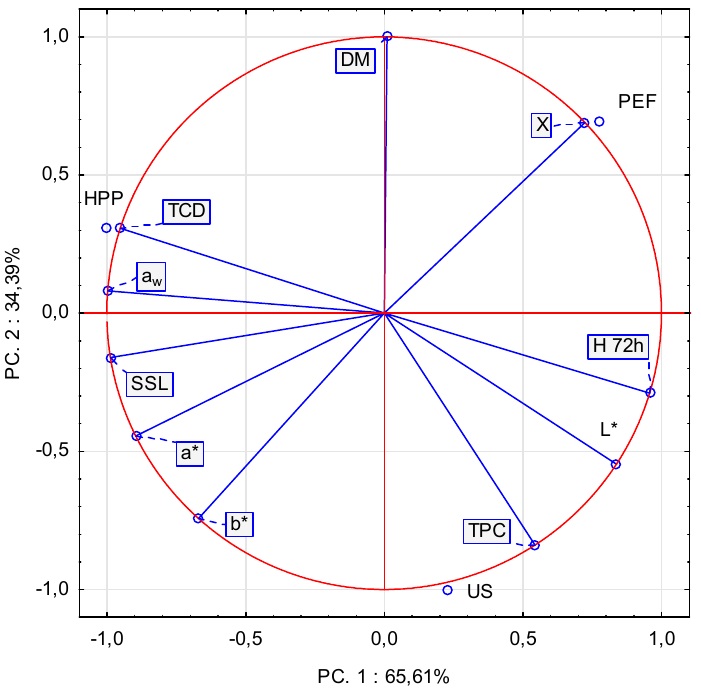
Figure 5. BiPlot of the results of principle component analysis which considered all investigated parameters. Cluster Analysis (CA) allowed to determine the two investigated groups: one con- sisted of PEF- and US-treated variants, whereas the second HPP-treated variants (Figure 6). In turn, the distance, which corresponds to dissimilarity, between PEF- and US-treated samples was 79%, meaning that samples subjected to the PEF and US treatments were more like each other than they were like HPP-treated material. Hence, the results of CA correspond to the results of PCA.